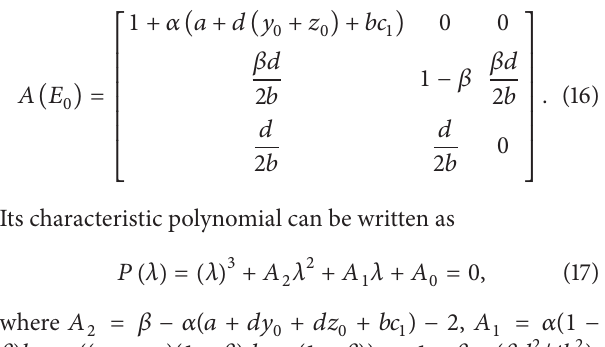
The regions Ω 𝐸 game for irrigation water will reach the Nash equilibrium by modulating limited times with random initial